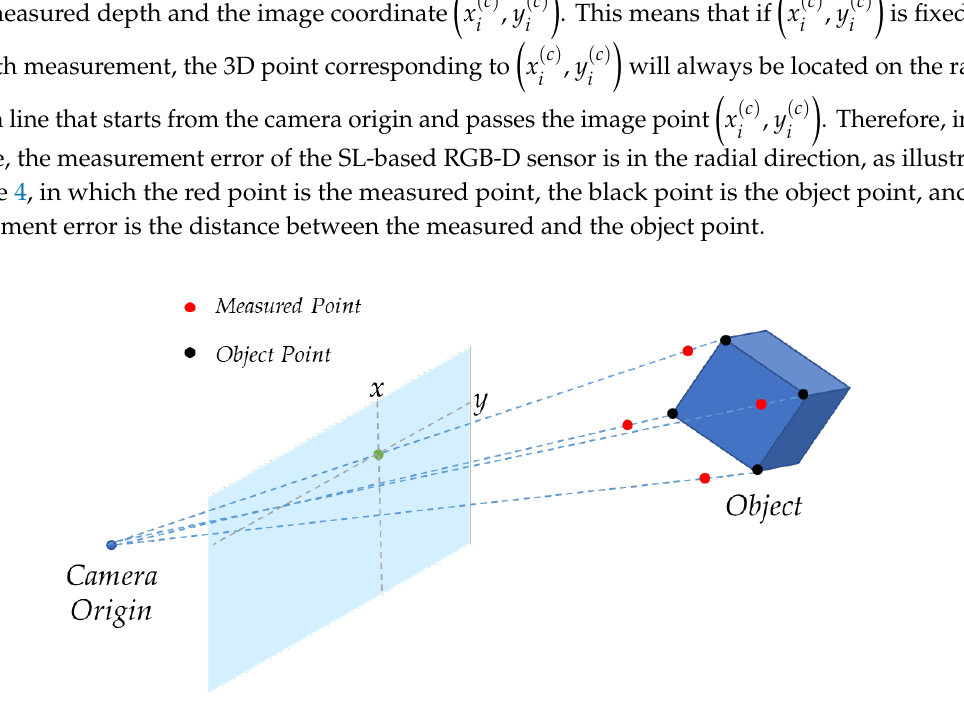
Figure 3. Residuals in different directions: ( a ) perpendicular direction, ( b ) camera’s plane normal direction, ( c ) radial direction .